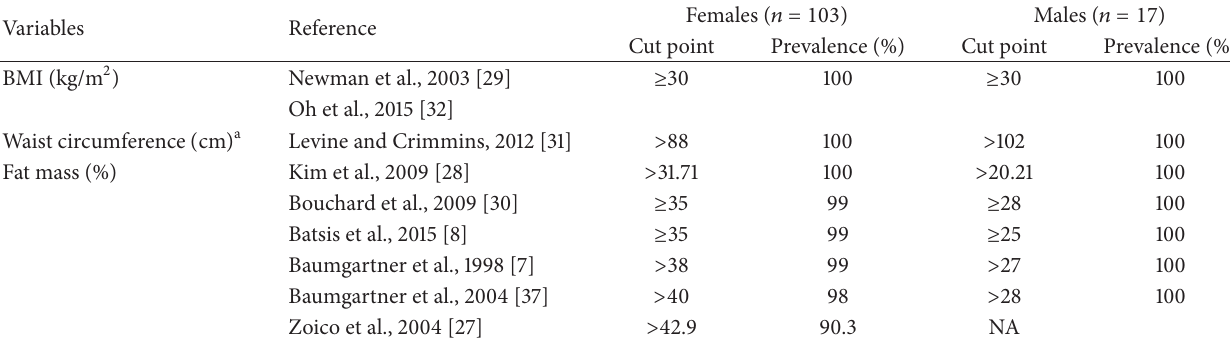
Table2:Prevalenceofobesityinstudycohort( 𝑛 = 120 )usingvarioussex-specificdefinitionsdeterminedbyanthropometricanddual-energy X-ray absorptiometry measurements amongst studies investigating sarcopenic